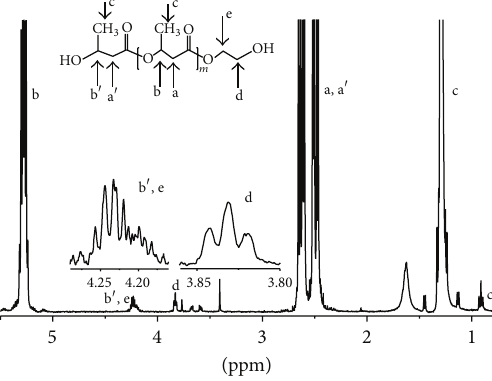
Figure 2: 1 H NMR spectra of PHB-diol.